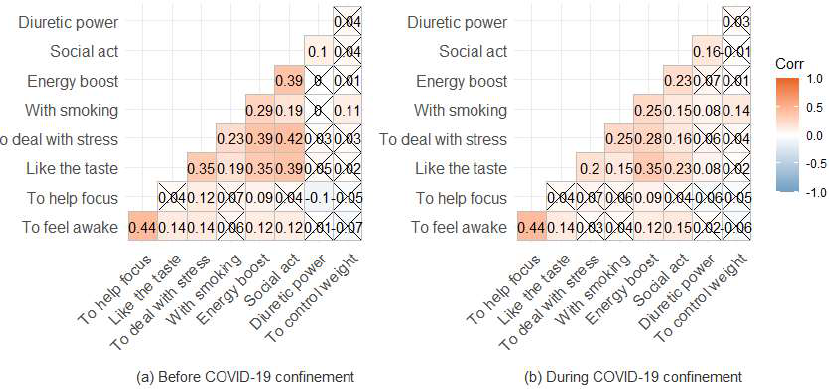
Figure 3. Kendall’s correlation coefficients for the reasons leading to coffee consumption ( a ) before and ( b ) during COVID-19 confinement (crossed values indicate non-significant correlations at 5%).